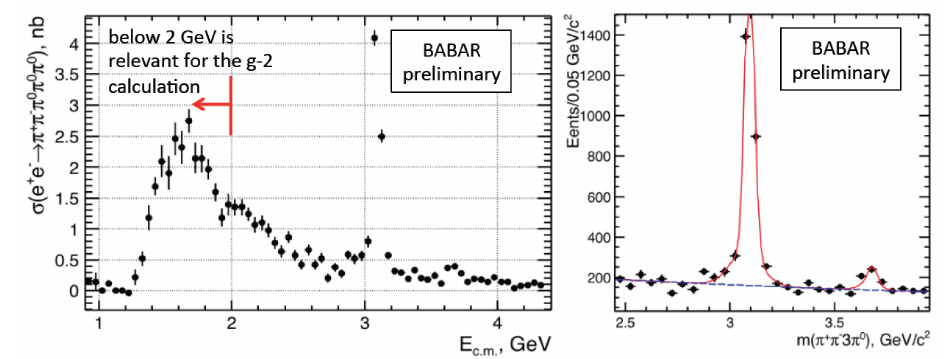
Figure 8. The measured e + e − → π + π − π 0 π 0 π 0 cross section. The right-hand plot shows an expanded view around the charmonium region.